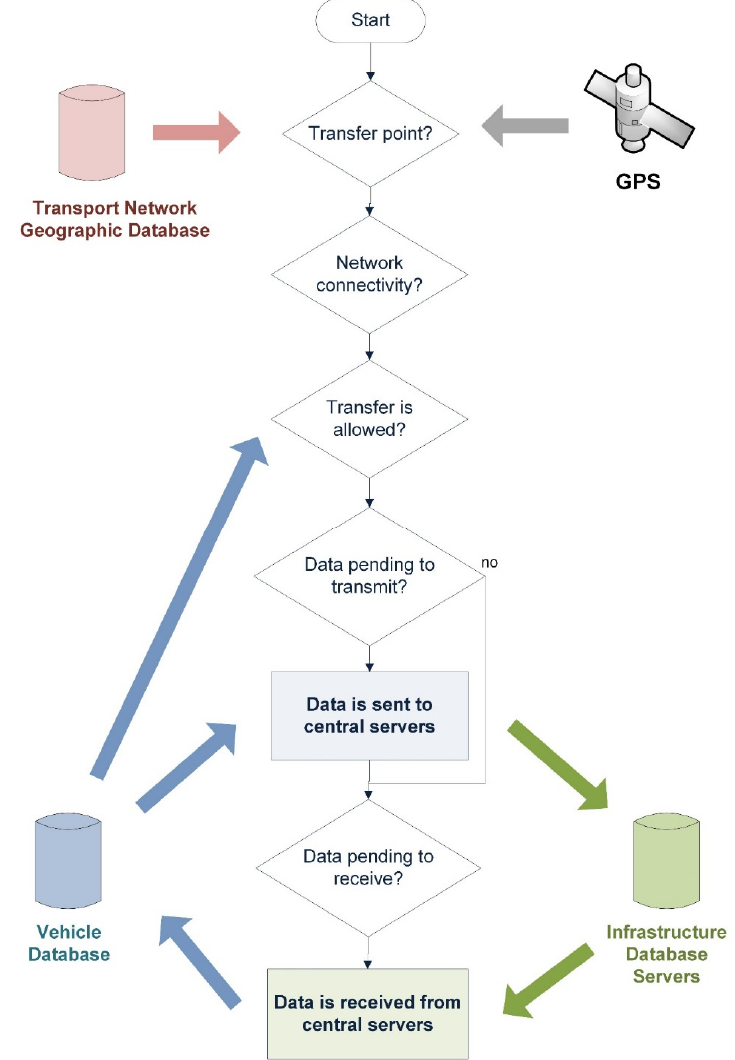
Figure 5. Schema of autonomous data transfer between vehicles and infrastructure.